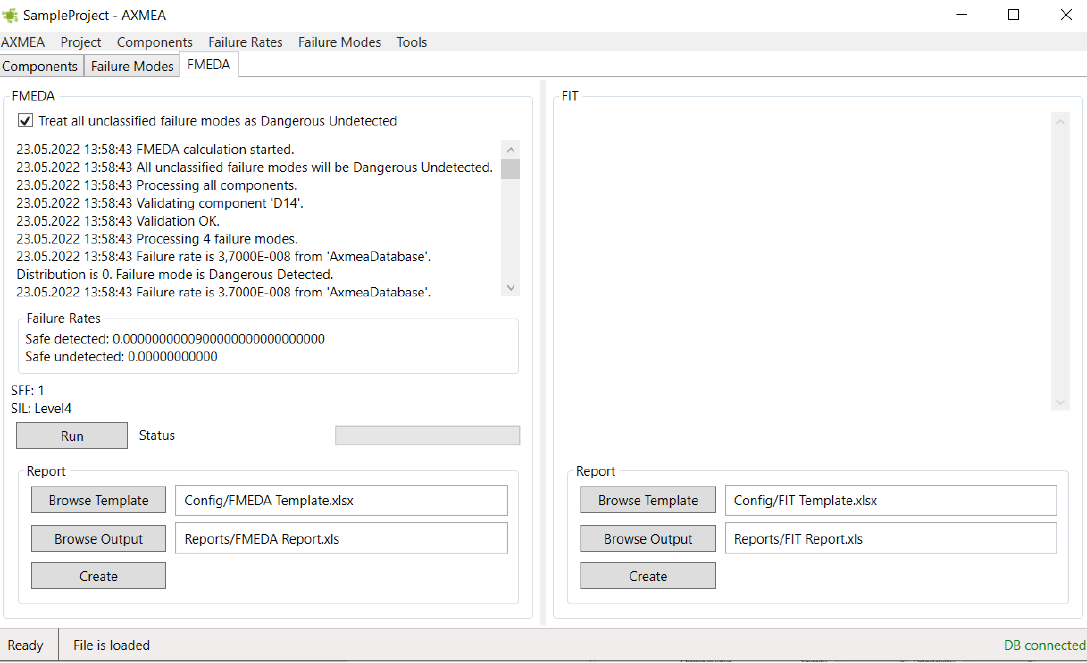
Figure 9. AXMEA tool: safety metrics calculation.